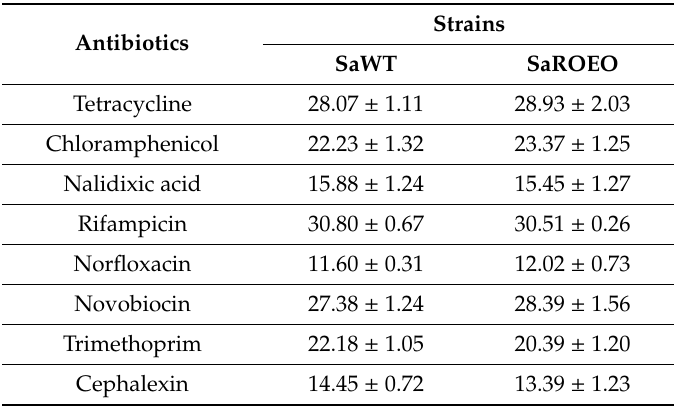
Table 3. Zones of growth inhibition (mm) for agar disk diffusion assays of Staphylococcus aureus USA300 (SaWT) and evolved strains (SaROEO) against antibiotics: 30 μ g tetracycline, 30 μ g sodium, 10 μ g trimethoprim and 150 μ g cephalexin. Each value represents the mean diameter of the inhibition halo ± standard deviation from three independent experiments.